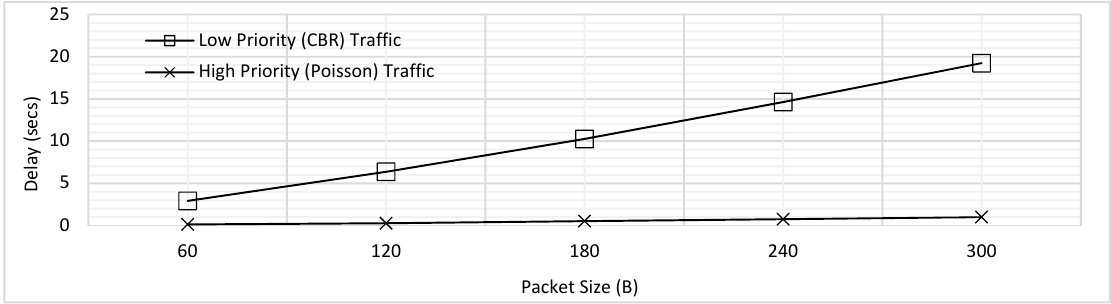
Figure 5. Comparison of Delay for Prioritization without Fragmentation.